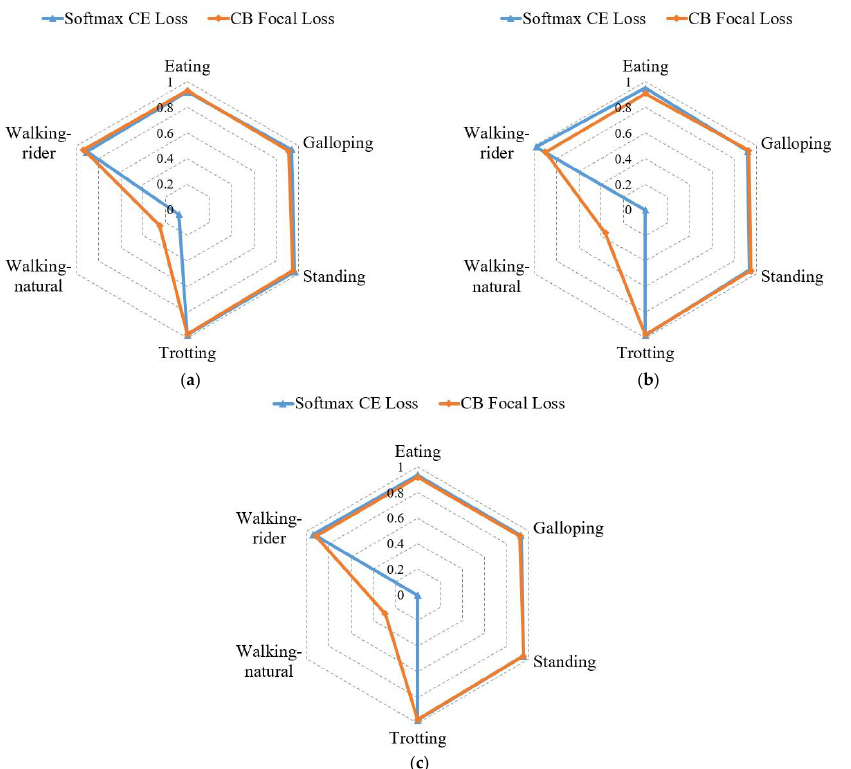
Figure 5. Precision ( a ), recall ( b ), and F1-score ( c ) comparison of each activity under softmax cross-entropy (CE) loss and class-balanced (CB) focal loss. In addition, experiments under different loss functions were conducted to verify the effectiveness of the CB focal loss, as illustrated in Table 4. The contrasting losses mainly included CS_CE loss, CB_CE loss, focal loss, and ACS loss, as mentioned in the “Optimi- zation” section. We found that CB focal loss combining CB loss and focal loss performed better than any of them used alone, which indicated that adding the CB term to the focal loss function improved the overall classification performance on the imbalanced dataset. In addition, the precision, recall, and F1-score of CS_CE loss and CB focal loss increased by different degrees, while both accuracies decreased compared with softmax CE loss. Specifically, the accuracy was only 83.79%, although the recall reached the highest value of 85.11%. This was because the recall of walking-rider was only 72.49%, although that of walking-natural was 69.16% (Figure 6). This result further verified that decreased accu- racy occurred when using balancing techniques on the imbalanced dataset. In addition, we found that the recall of majority classes decreased while that of minority classes in- creased when using CS_CE loss and CB focal loss (Figure 6). This result revealed that both